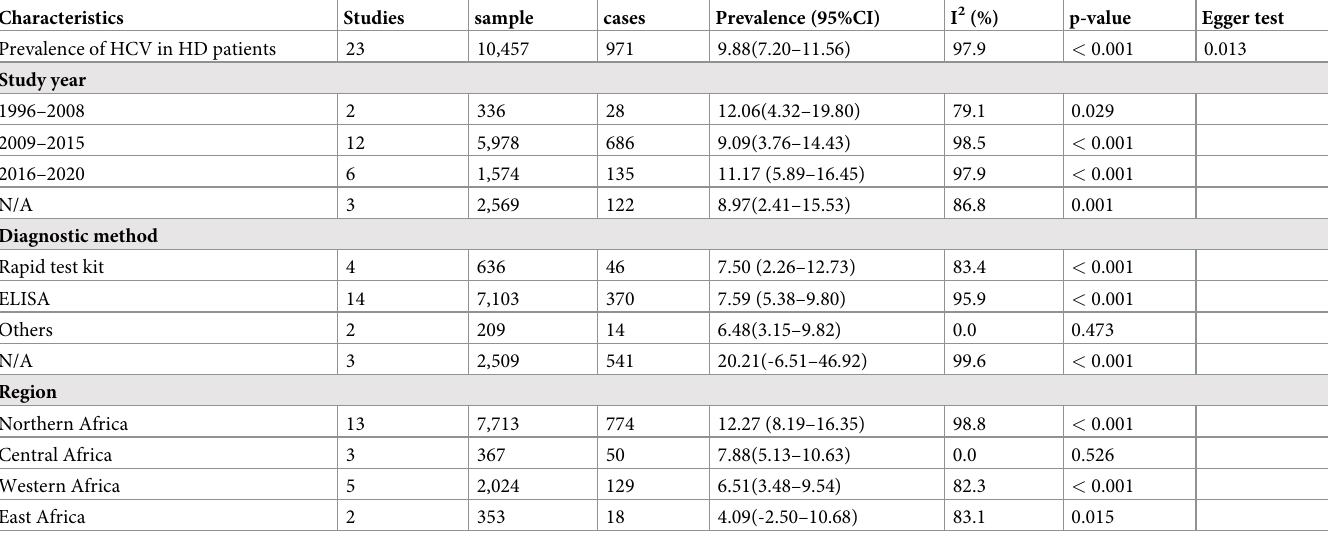
Table 2. Prevalence of HBV among HD patients in Africa.